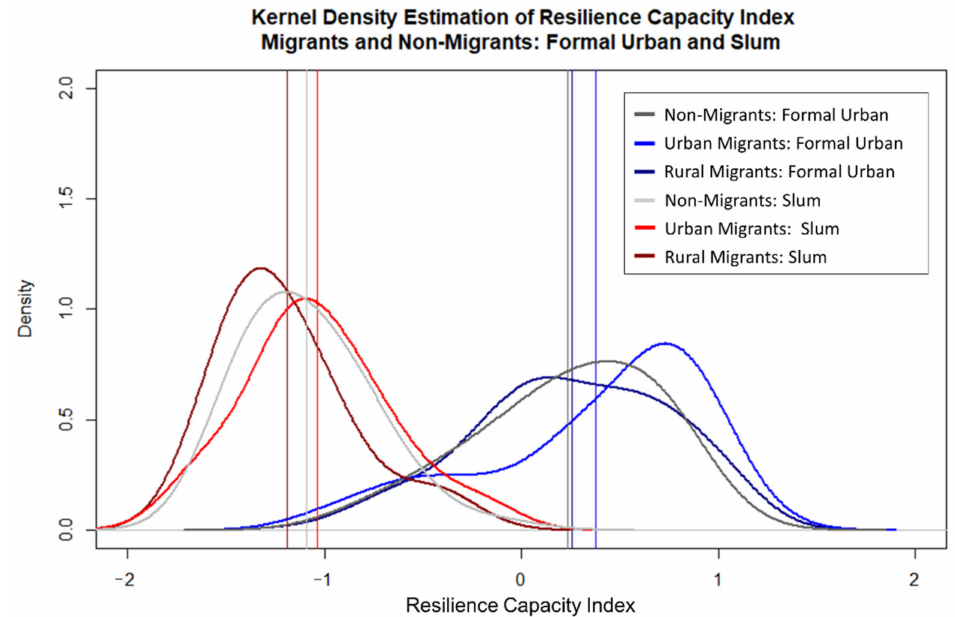
Figure 6. Kernel density estimation of RCI for the six analyzed sub-groups.